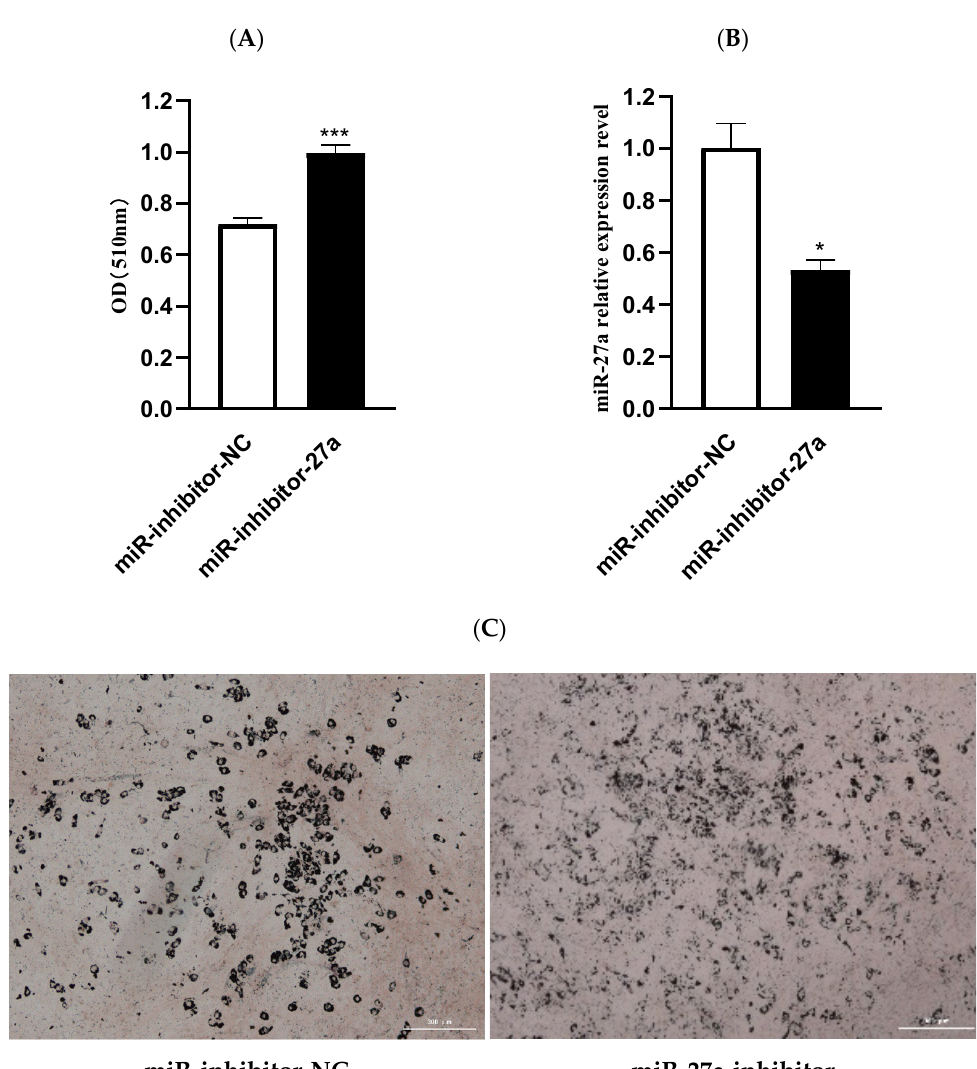
Figure 3. Effect of miR-27a inhibitor on ovine preadipocytes. ( A ) miR-27a expression following miR-27a inhibitor treatment; ( B ) cellular lipid content as determined by spectrophotometry; ( C ) change in lipid droplet accumulation in ovine preadipocytes after treatment with miR-27a inhibitor. * p < 0.05; *** p < 0.001.